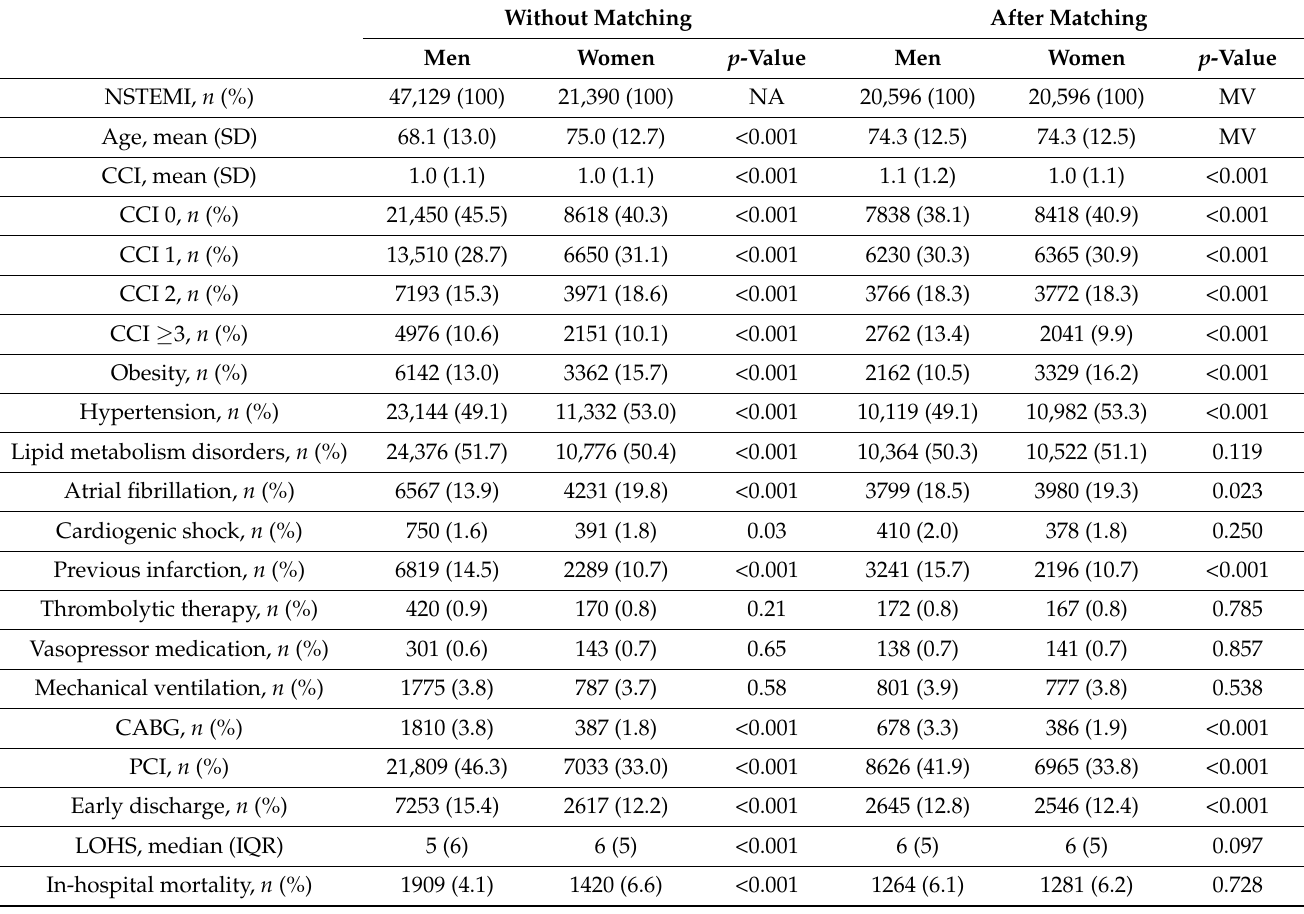
Table 3. Clinical characteristics and hospital outcomes, before and after matching by age, for men and women suffering from an